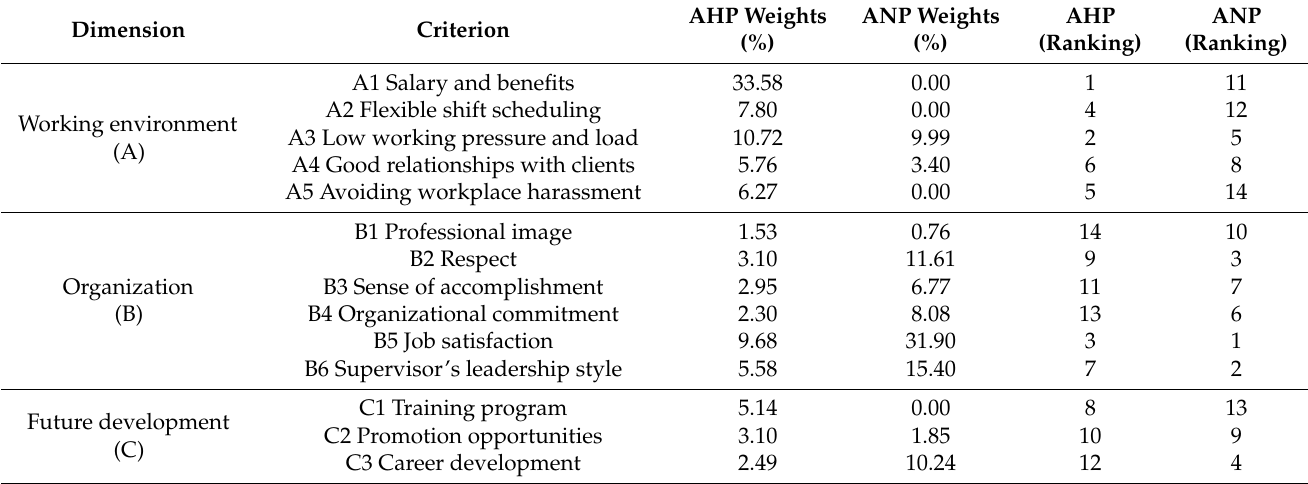
Table 3. Comparison of critical success factors weights in AHP and